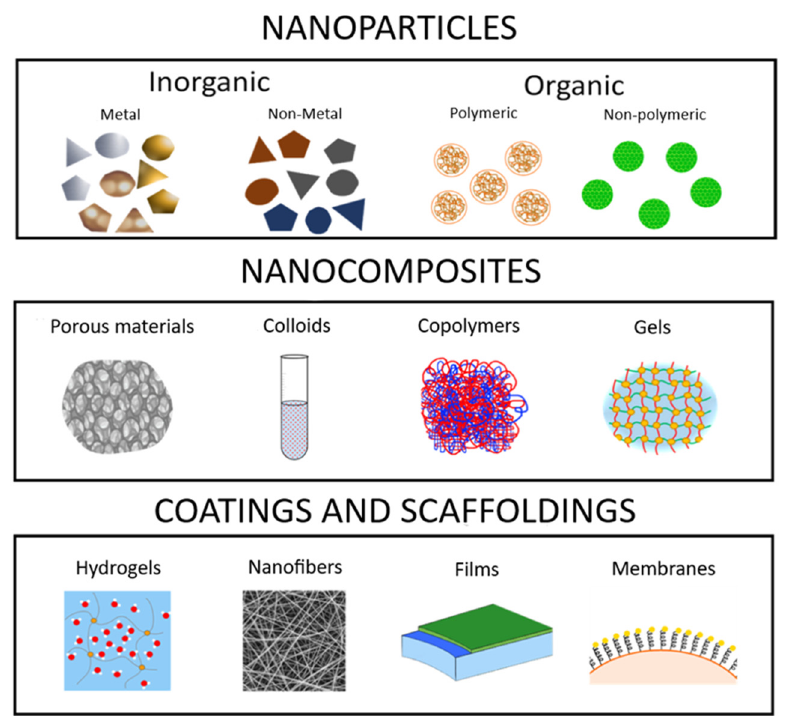
Figure 1. Nanomaterials with potential use for wound treatment. Nanomaterials cover several groups of materials including nanoparticles, nanocomposites and different coatings and scaffolding materials. Nanoparticles can be divided into two groups depending on their chemical basis, which comprises inorganic (metal—Ag, Au, Zn, Cu etc.; non-metal—for example, Se) and organic (polymeric and non-polymeric) nanoparticles. From the perspective of nanocomposites, four groups can be recognized: porous materials, colloids, copolymers and gels. For the wound coating and scaffolds, hydrogels, nanofibers, films and membranes can be used. Adapted from [25] under a CC BY 4.0 license.